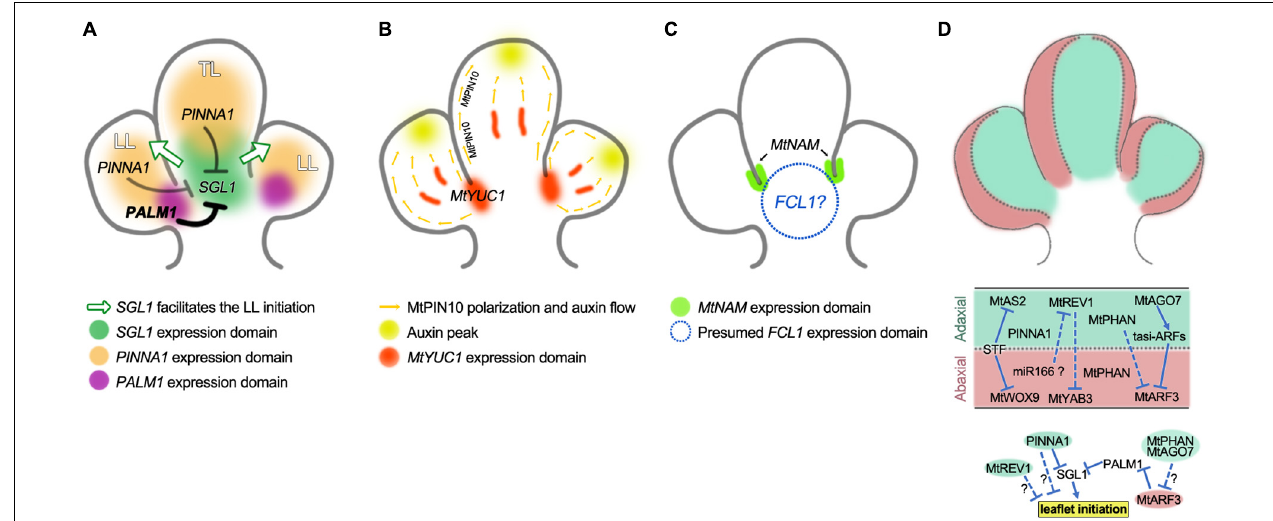
FIGURE 3 | Genes-network controlling the trifoliate pattern formation of M. truncatula . (A) Model for LFY/SGL1 pathway in trifoliate pattern formation with the diagram representing the P3 leaf primordium of three leaflet primordia but without stipule primordia. SGL1 is the key indeterminacy factor that maintains a transient morphogenetic activity and promotes the initiation of LL primordia (green arrows), while both PINNA1 and PALM1 negatively regulate the morphogenetic activity by directly inhibiting the expression of SGL1 . PINNA1 acts alone in the TL primordia and plays a secondary role in the LL primordia (gray lines), where PALM1 functions as a master role (bold line). (B) Model for auxin actions during the trifoliate pattern formation. MtPIN10 polarization mediates auxin transport leads to the formation of auxin peaks to induce both TL and LL primordia bulging, and the MtYUC1 encoding auxin biosynthetic enzyme plays an essential role in LL growth. (C) Regulation of boundary development. MtNAM facilitates the separation of TL and LL primordia by inhibiting cell proliferation in the boundary region, FCL1 also plays a key role in the development of boundaries between TL and LL primordia. (D) Schematic view of the adaxial–abaxial patterns in leaflet primordia of the P3 leaf (upper panel), regulatory networks for the establishment and maintenance of adaxial–abaxial polarity (middle panel), and links between adaxial–abaxial polarity genes and the leaflet initiation (lower panel). MtAS2 , MtAGO7 , MtREV1 , and PINNA1 are expressed in the adaxial domain of leaf primordia, MtWOX9 , MtARF3, and MtYAB3 are expressed in the abaxial domain, and MtPHAN is expressed in both of the adaxial and abaxial domain, while STF is expressed at the adaxial–abaxial junction (middle domain). STF directly represses the expression of MtAS2 and MtWOX9 , while MtPHAN and MtAGO7 negatively regulate transcription of MtARF3 , MtREV1 represses the expression of MtYAB3 . The adaxial–abaxial polarity genes MtPHAN , MtAGO7, and MtARF3 regulate the leaflet initiation through the LFY/SGL1 pathway. The adaxial polarity gene MtREV1 regulates the leaflet initiation through unknown mechanisms. The PINNA1 is mainly expressed in the adaxial domain and it